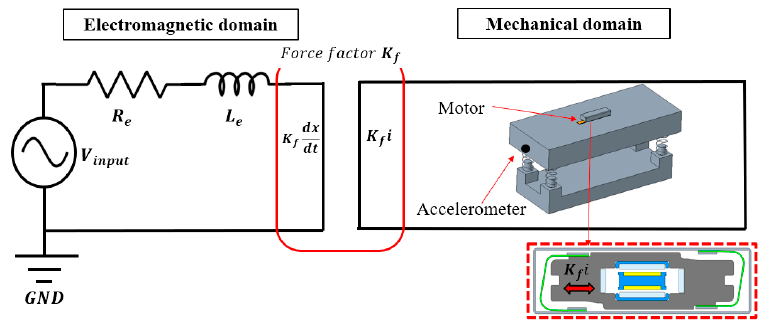
Figure 12. E–M coupling model.